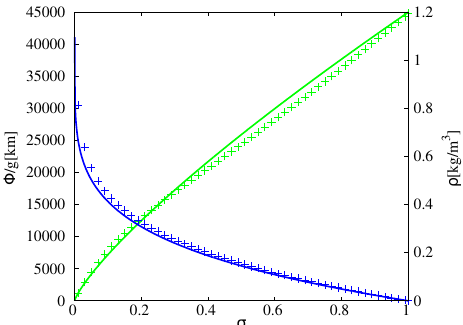
Fig. 4. Diffusivity profiles used in the experiments. The symbols represents the data from GLOBO and the lines their fitting function. The ‘average’ profile is shown in red, while the ‘peaked’ profile is shown in green. The functional form of both profiles is described by Eq. (26).